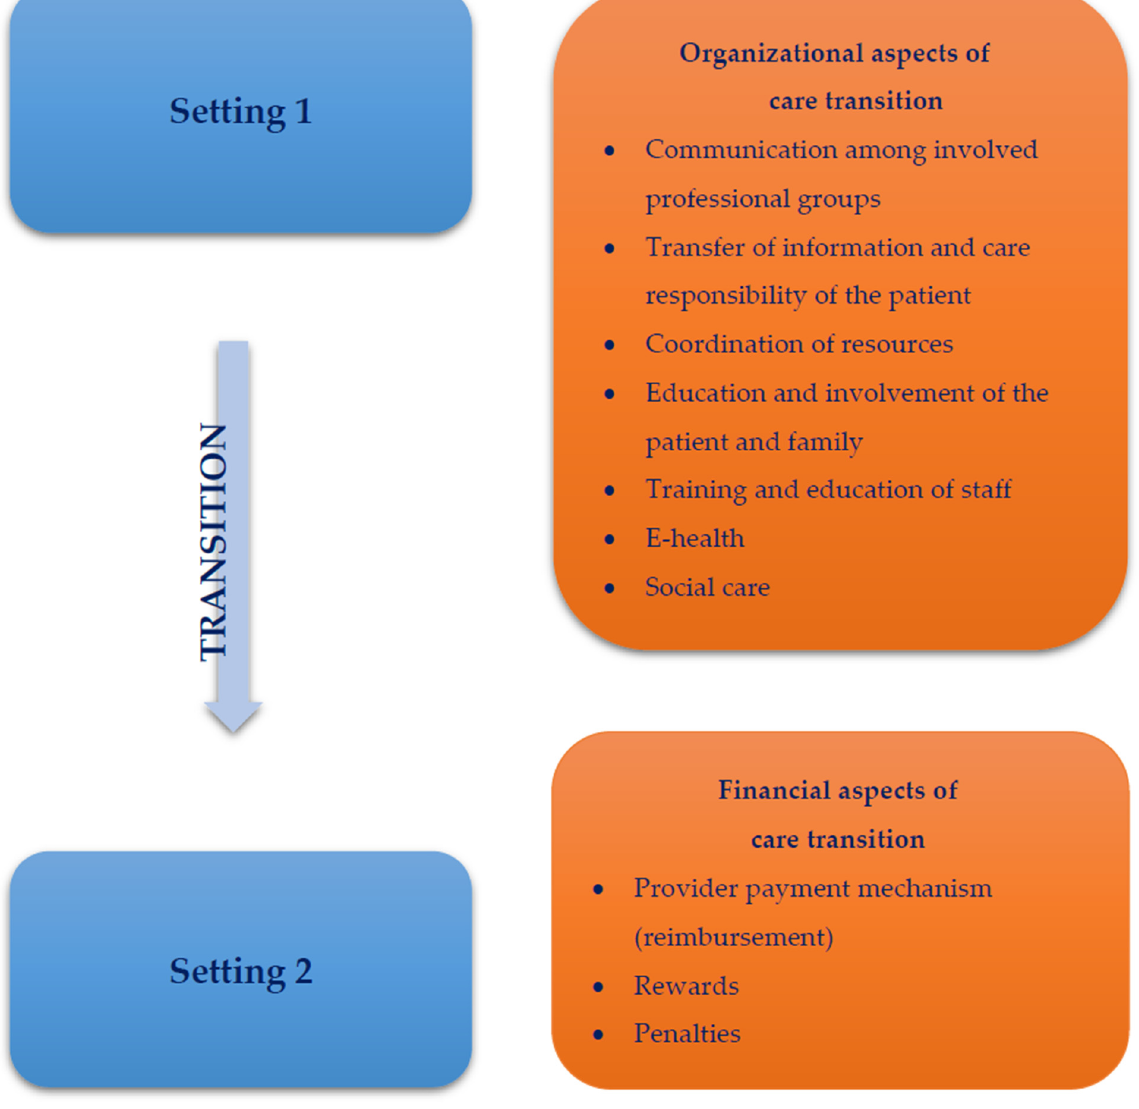
Figure 1. Care provision aspects that affect care transition.